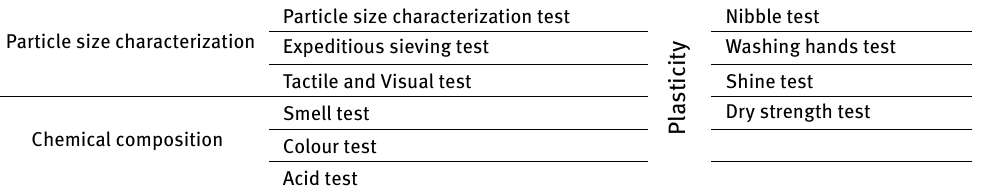
Table 10: Field tests